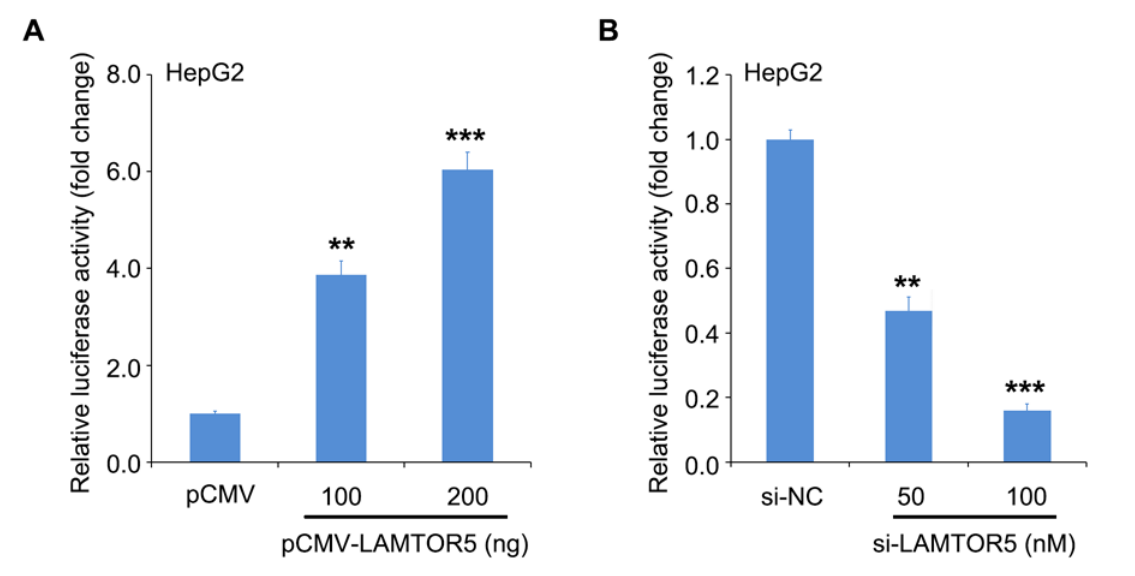
Figure 2: LAMTOR5 is capable of activating the transcription of GLUT1. (A, B) The effect of LAMTOR5 on GLUT1 promoter was determined using luciferase reporter assay in HepG2 cells transiently transfected with LAMTOR5 vector or siRNAs. **P < 0.01, ***P <